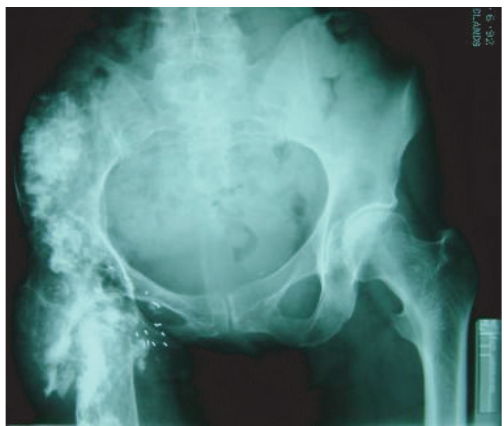
Figure 3: Three months following the left total hip arthroplasty. There appears to be a stress fracture through the floor of the acetab- ulum.